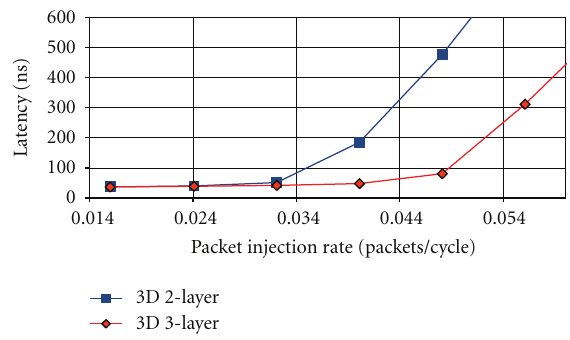
Figure 26: Latency for 2-layer and 3-layer implementations of ami25 .